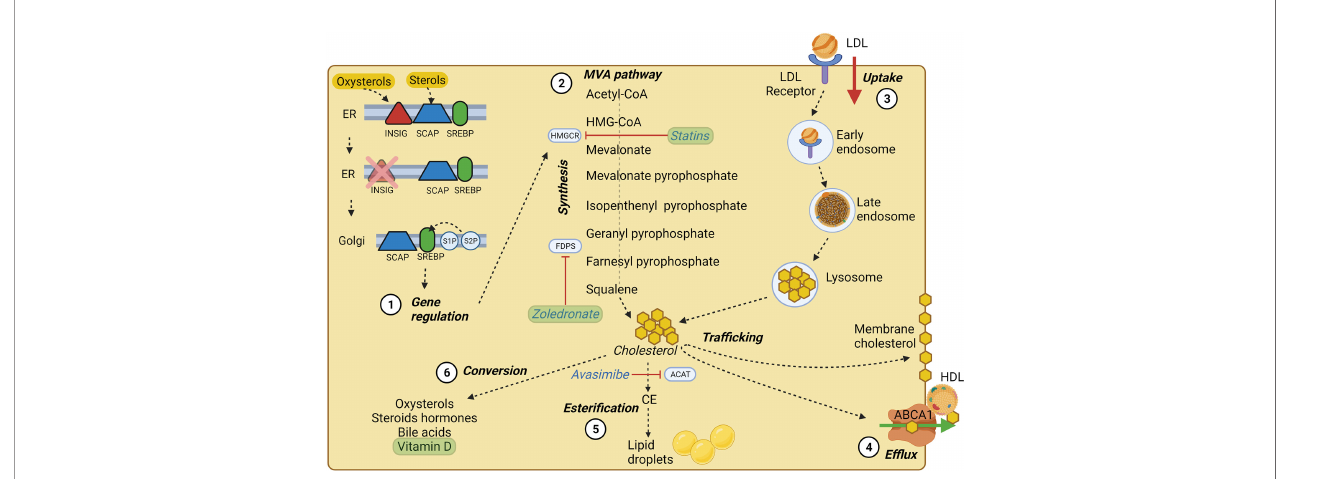
FIGURE 1 | Cholesterol homeostasis main processes. (1) SREBP processing at the ER membrane and Golgi apparatus; in high cholesterol condition, SREBP is retained at the ER membrane by INSIG and SCAP, which sense oxysterols and sterols, respectively. At low cholesterol condition, SREBP can be transported to the Golgi apparatus and cleaved by S1P and S2P proteases. Cleaved SREBP can enter the nucleus and trigger the transcription of crucial MVA pathway genes. (2) Main steps of cholesterol synthesis through the MVA pathway, of which HMGCR represents the rate-limiting enzyme. (3) LDL-cholesterol intake via LDL-receptor mediated endocytosis. (4) Cholesterol ef fl ux by ABCA1 transporter, which employs ATP molecules to deliver cholesterol and lipids on apoA-I, triggering the assembly of nascent HDL. (5) ACAT enzyme mediated cholesterol esteri fi cation to fatty acids tightly packaged and stored in the core of intracellular lipid droplets, which represent a ready storage of lipids that can be used without investing energy in biosynthesis. (6) Cholesterol conversion in its main derivatives, some of which may play a role in BC pathology and progression. The main cholesterol homeostasis inhibitors and their targets are underlined in blue, while drugs and substances used in clinical trials (see Table 1 ) are shown in green. Created with